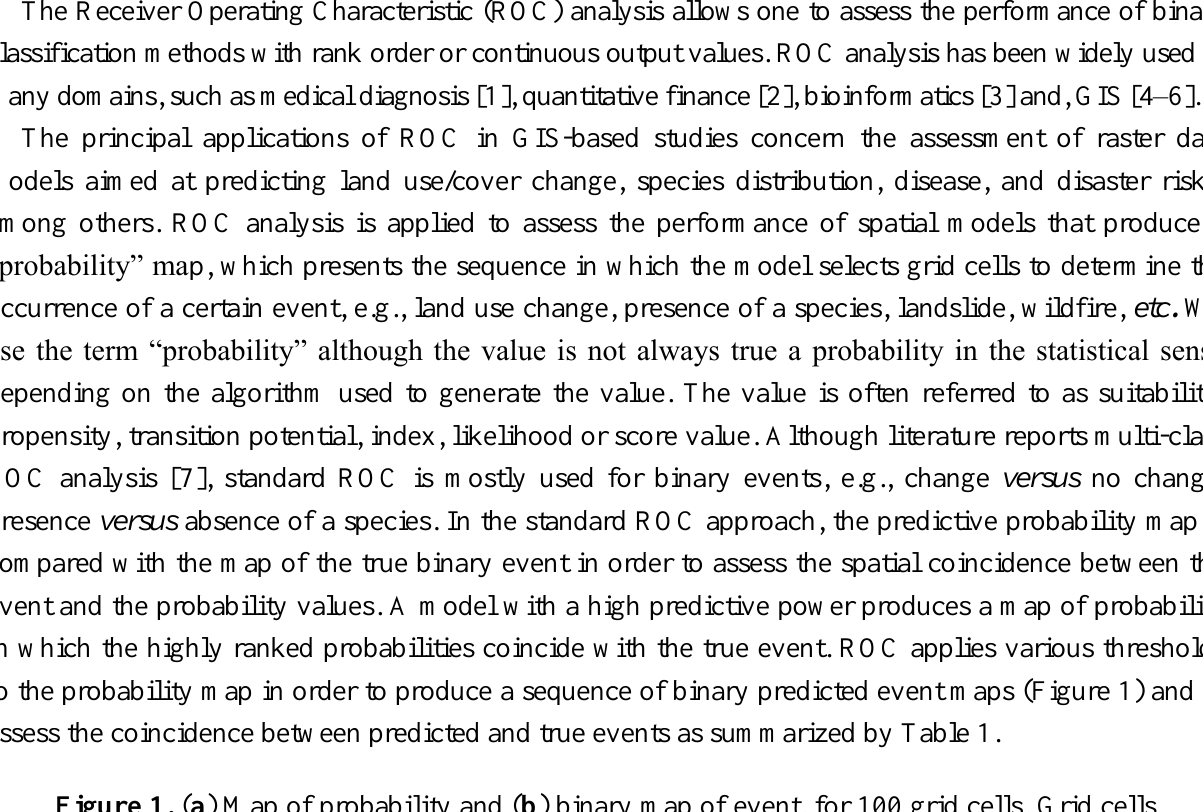
Figure 1. ( a ) Map of probability and ( b ) binary map of event, for 100 grid cells. Grid cells with high to medium probability (black and dark grey cells) tend to coincide with the 11 event black grid